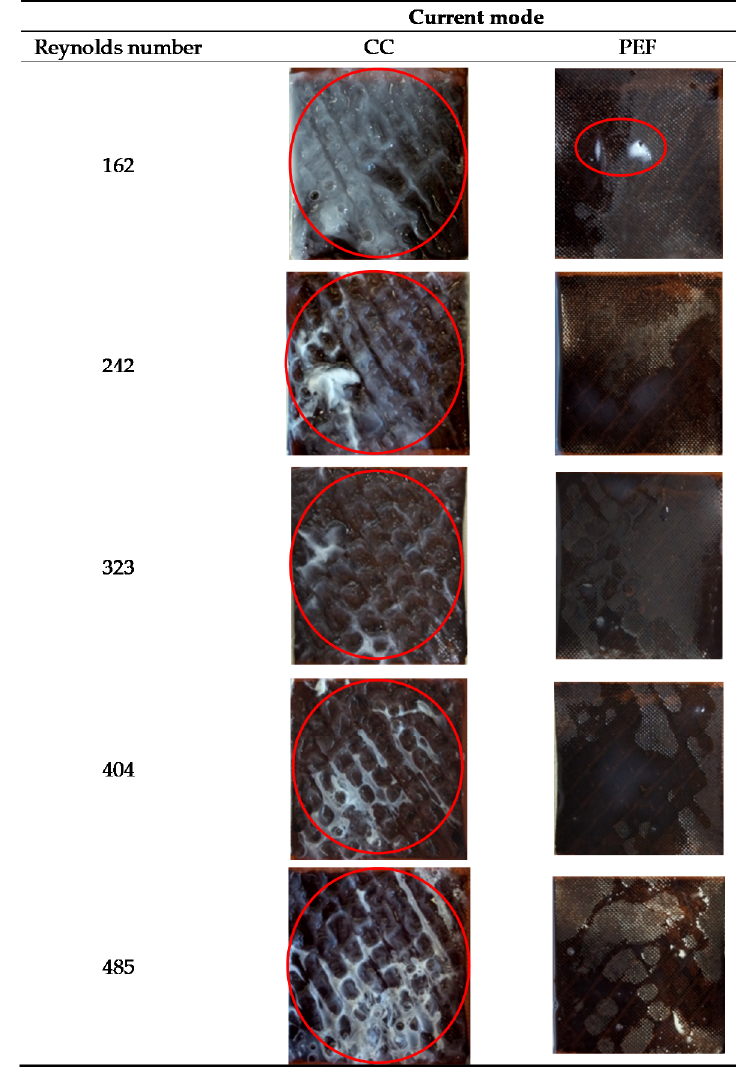
Figure 6. Photographs of the bipolar membrane (BPM) cationic interface in contact with milk after EDBM carried out in di ff erent flow rates (corresponding to indicated Reynolds numbers) and current modes (CC and PEF). The red circles indicate a fouling.